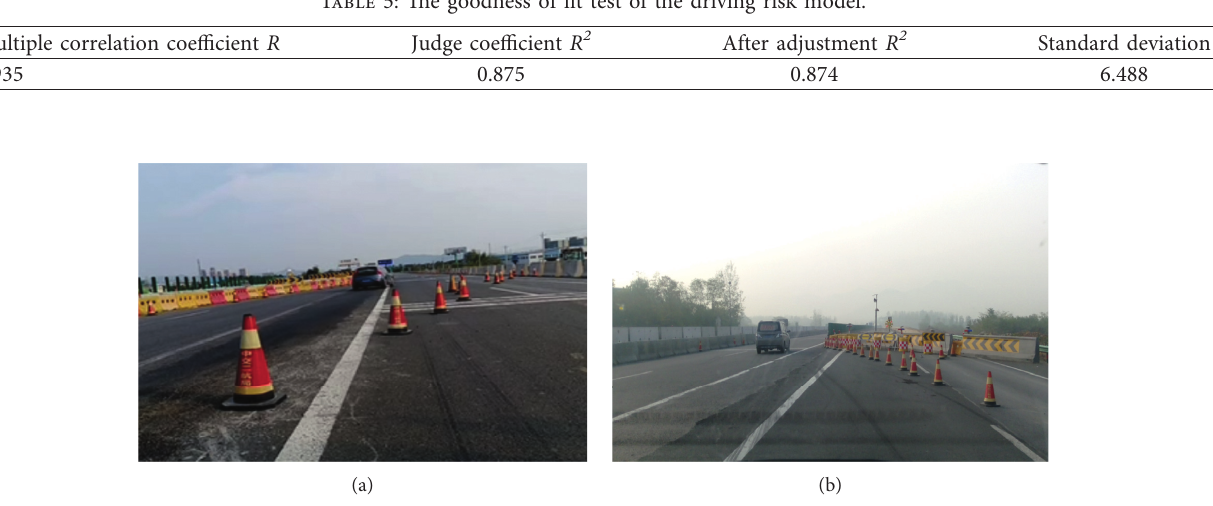
Figure 9: Scene photos of the work